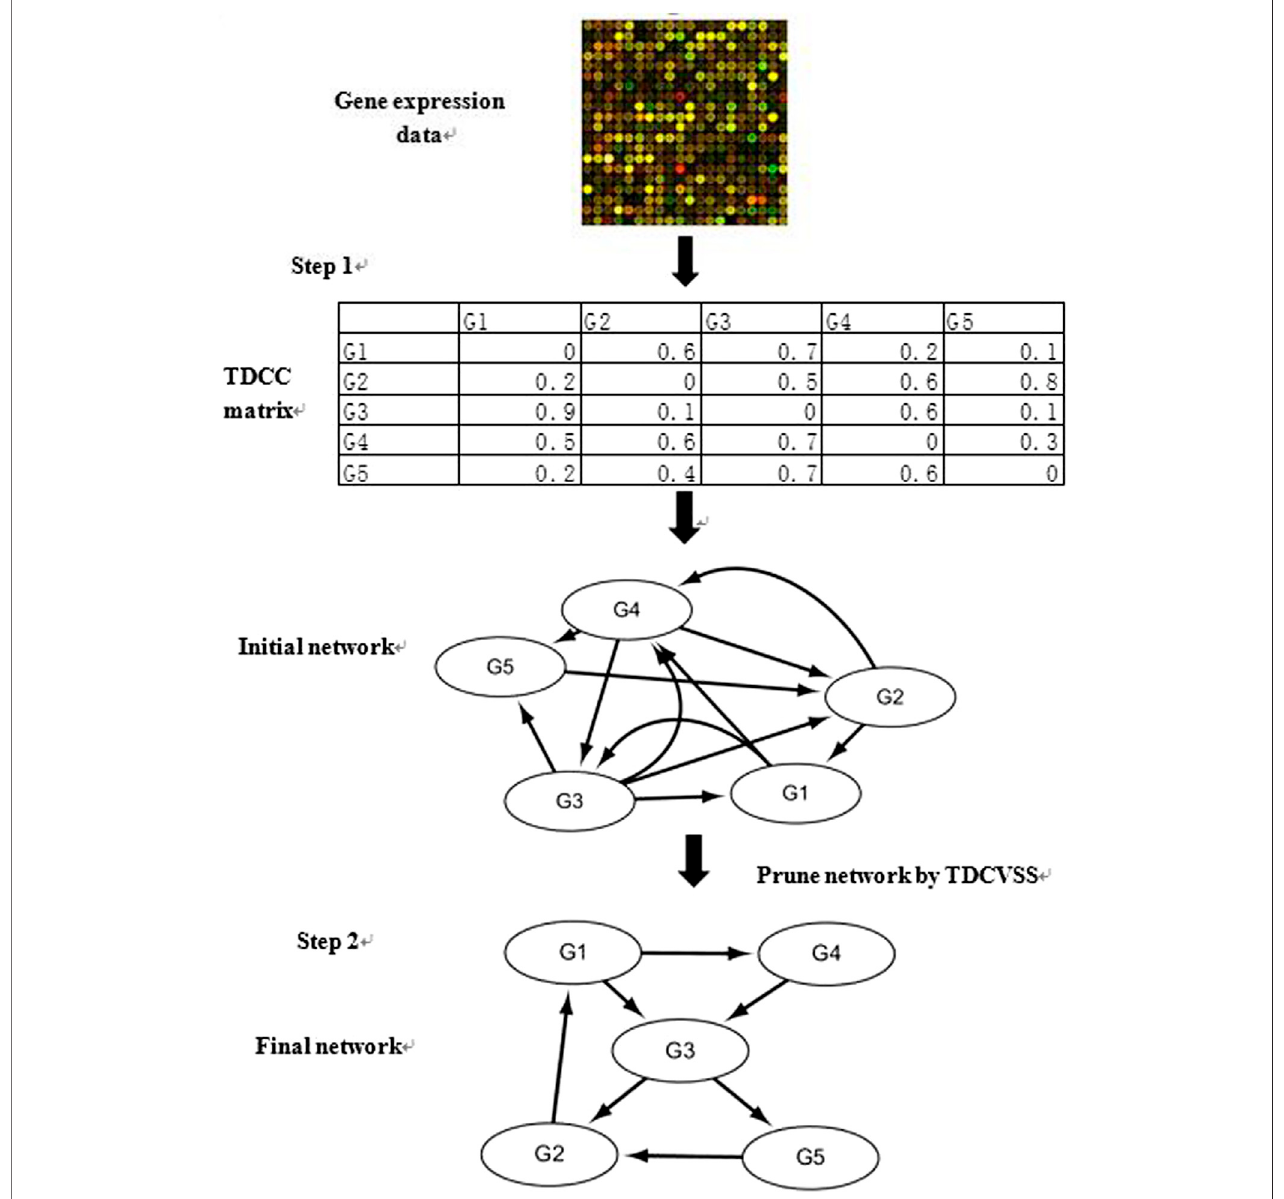
FIGURE 4 | Flowchart of gene regulatory network